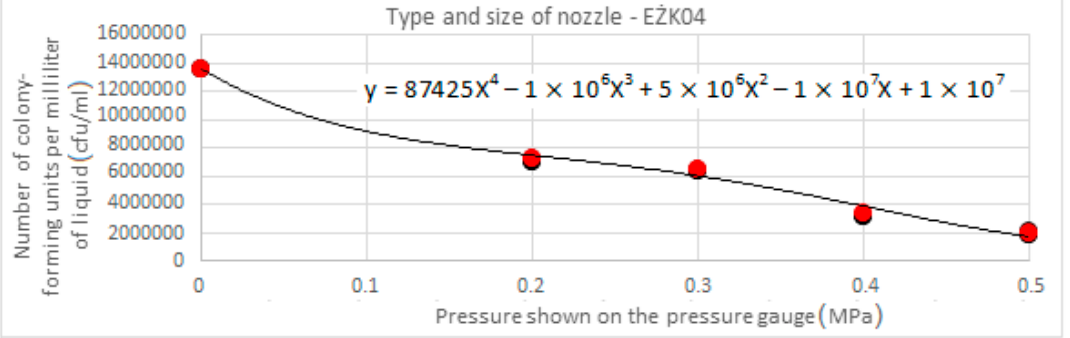
Agriculture 2020 , 10 , x FOR PEER REVIEW Figure 4. The influence of pressure on survival of cfu/mL of liquid for E Ż K03.